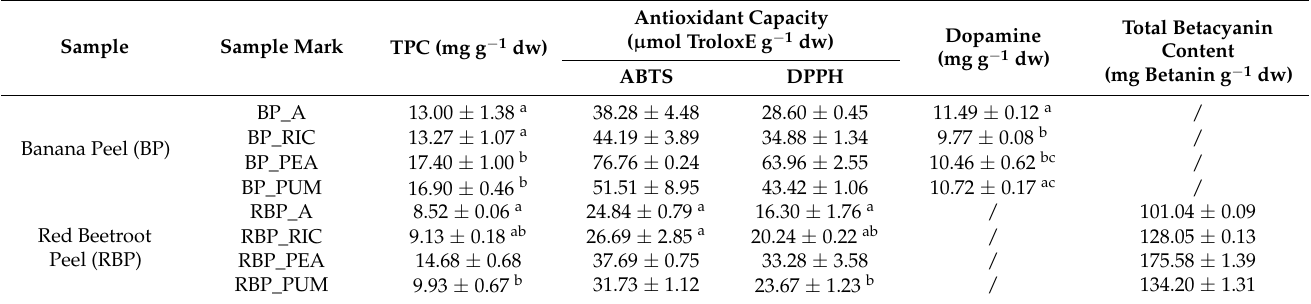
Table 4. Bioactive characterization of edible films.